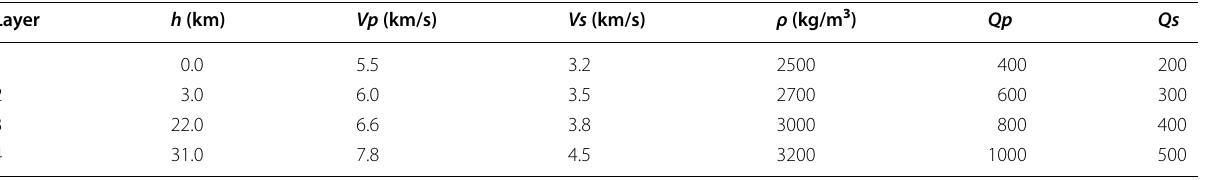
The S-wave models are assumed by scaling the P-wave velocities by a factor of 1 / √ 3